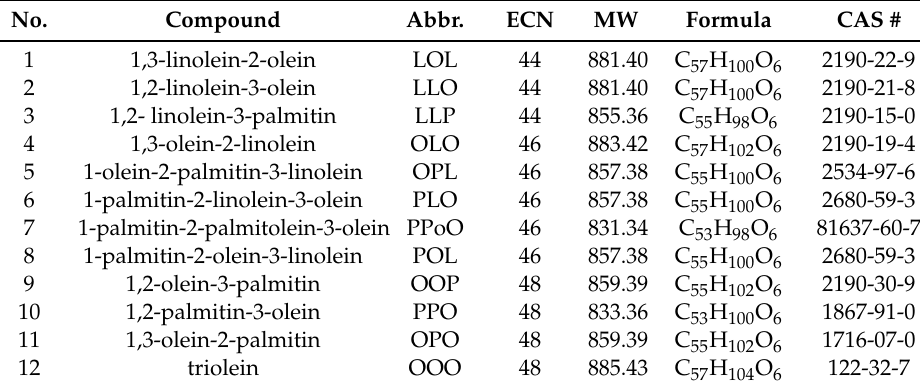
Table 2. Information of triglyceride reference